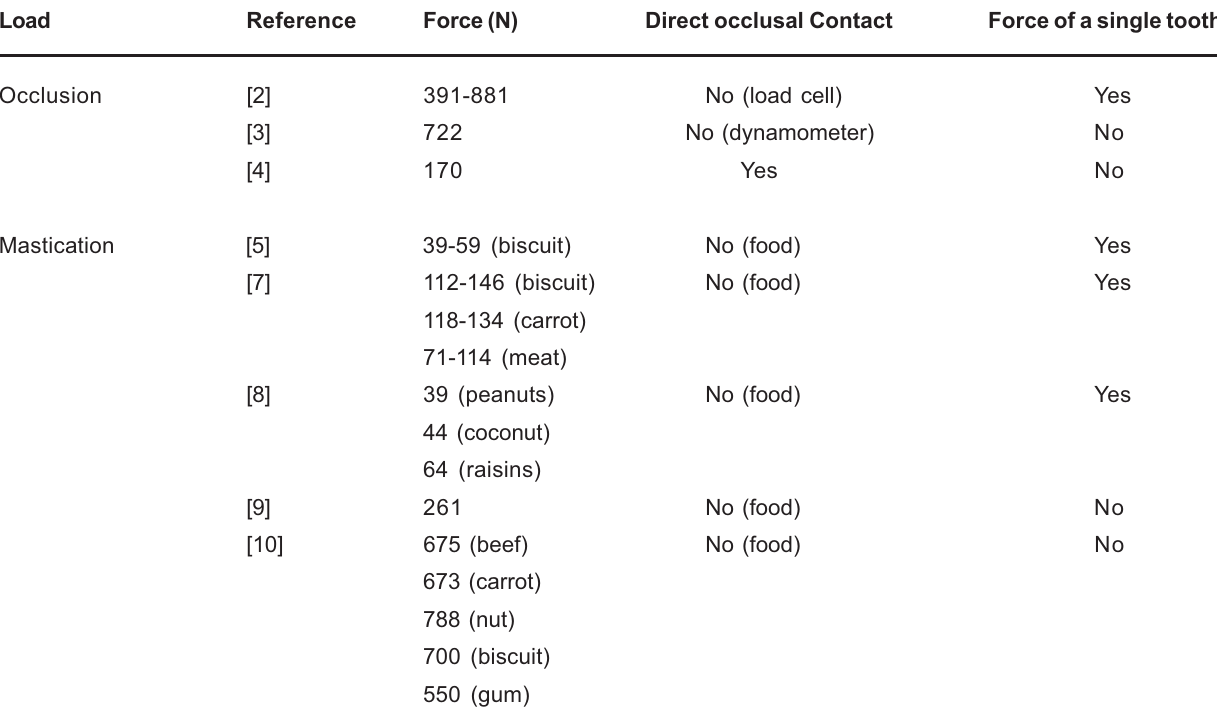
TABLE 1- Occlusion and mastication loads for the first molar